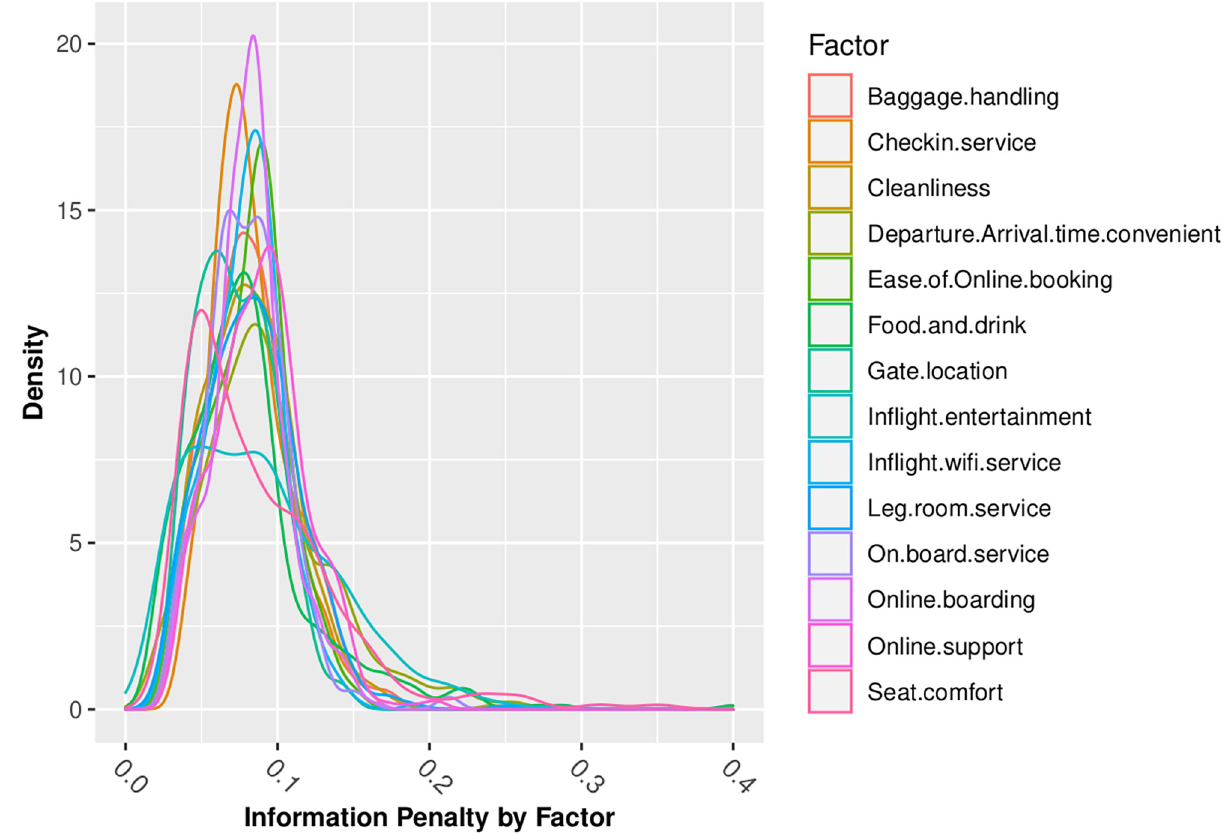
Fig 6. Information penalty (Jeffreys Divergence) assuming normal